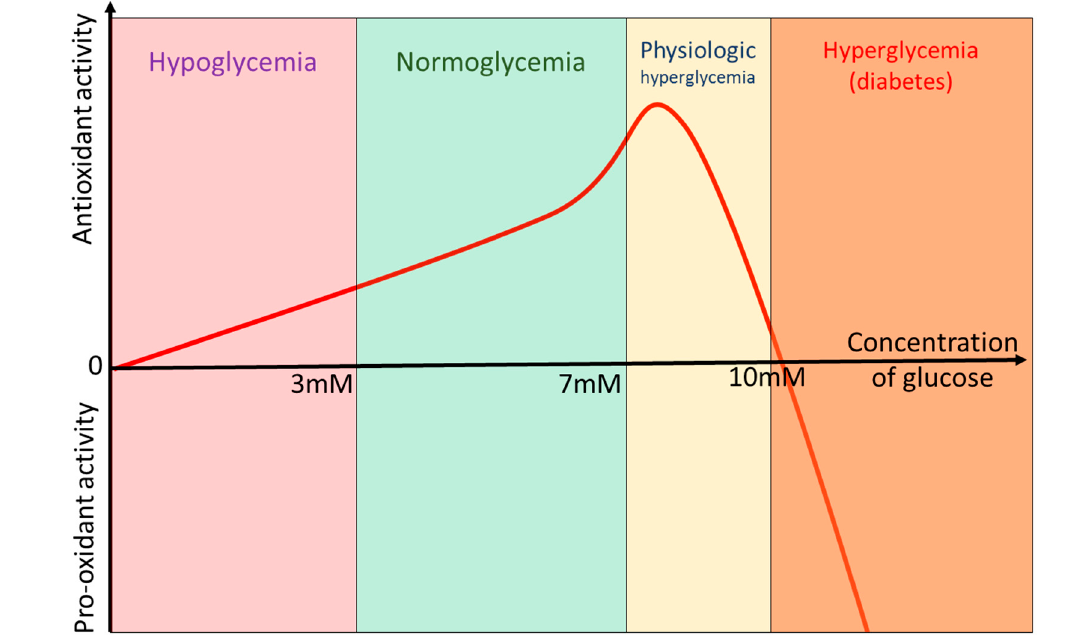
Figure 3. The dependence of redox effects of glucose on its concentration (hypothetic relationship suggested by the authors). Hypothetical simplified model describing the influence of the blood concentration of glucose on redox potential in human organisms. Multiple additional factors influencing redox potential such as concentration of oxygen, availability of amino and fatty acids, type of cells and effects of either hormones (insulin, glucagon) or cytokines are not considered. Concentrations of glucose as well as the shape of the curve are roughly estimated and not confirmed by actual experiments and may significantly vary depending on conditions and tissue type.